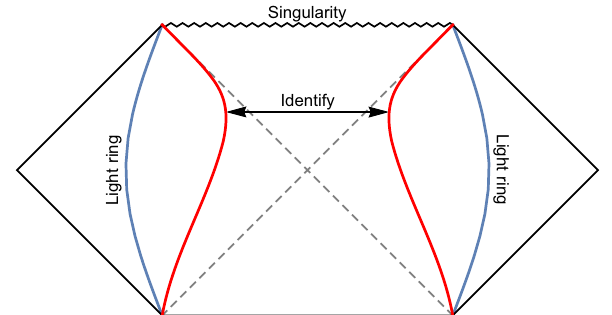
Fig. 1 The conformal diagram of a slowly pinching WH. The WH is constructed by gluing two Schwarzschild space-time at r = r 0 ( t ) (the red lines), which start at somewhere inside the light ring and end at the Schwarzschild radius at a finite t . The blue lines show the light rings of the Schwarzschild